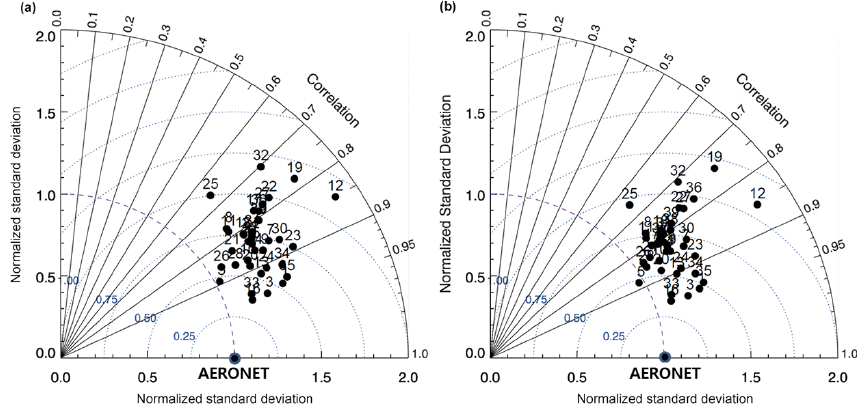
Figure 10. Taylor diagrams comparing the retrieved AODs and the values obtained from AERONET sun photometer measurements during the DRAGON-2012 campaign. (a) Comparison of results from the original AOD, (b) comparison of results from the new AOD. The numbers above each symbol indicate the number of the DRAGON-NE Asia sites, as listed in Table